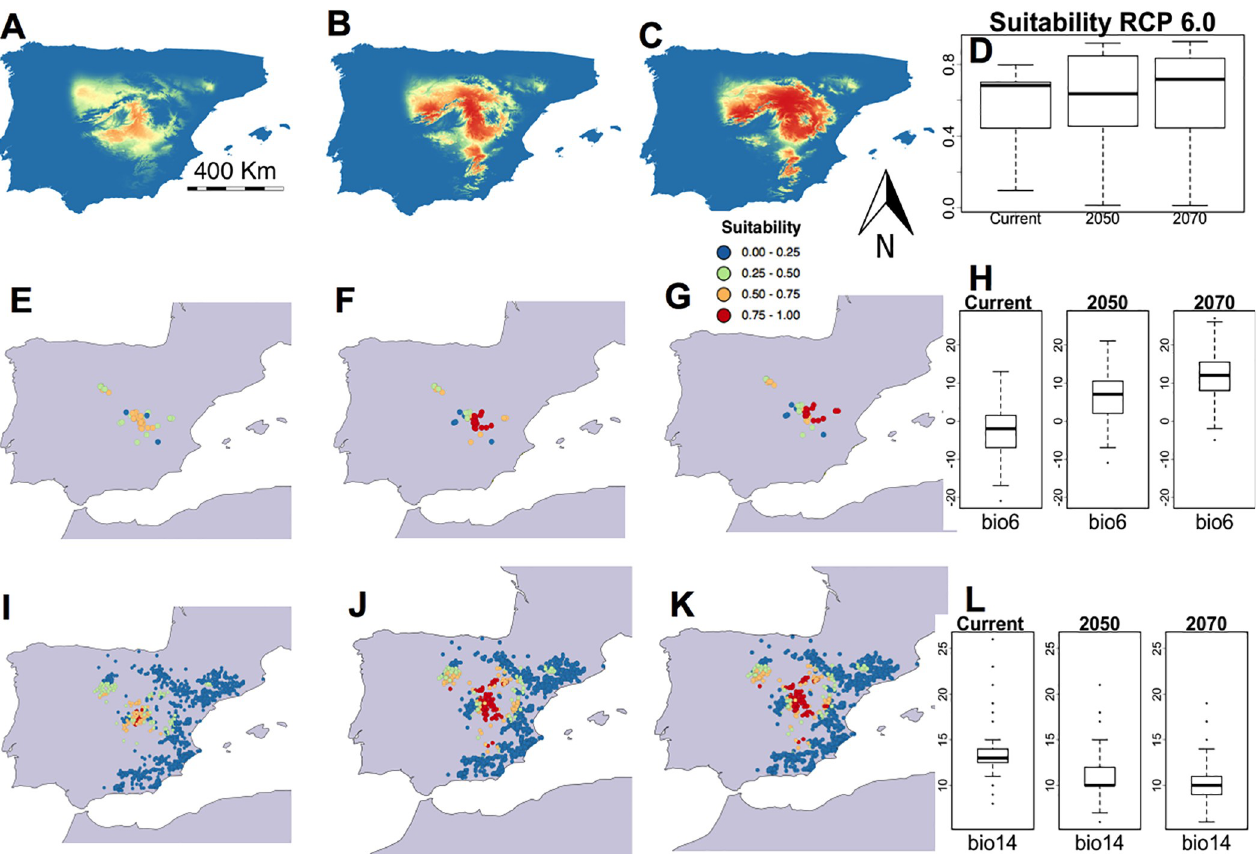
Fig 4. Habitat suitability predicted by the MaxEnt models for G. bermejoi under the RCP 6 scenario. Habitat suitability map for the current climatic conditions (A), and for those predicted for 2050 (B) and 2070 (C). (D) Habitat suitability values (R software standard box-plot) in the current climatic conditions, and under those predicted for 2050 and 2070 measured at the sites where the taxon is currently found. In E, F and G, we show the bioclimatic suitability at the sites where G . bermejoi is currently found. A color code was used to express the different intervals of habitat suitability. (H) These box-plots show the evolution of the values of the Bio 6 variable (the minimum temperature in the coldest month) measured at the sites where G . bermejoi is currently found. Bioclimatic suitability was also measured at each location, with gypsum soils indicated by the presence of O . tridentata . These values are shown in maps I, J and K, for the current climatic conditions, and for the conditions predicted for 2050 and 2070, respectively. (L) These box-plots are similar to those in (H) but representing the values of the Bio 14 variable (precipitation in the driest month), also measured at the locations where G . bermejoi is currently found.